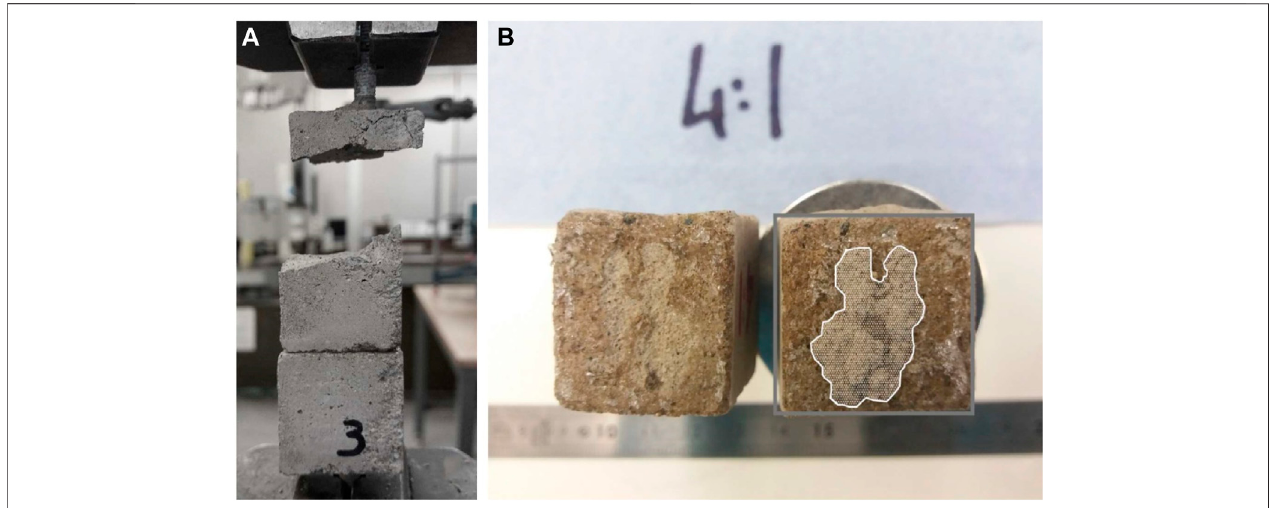
FIGURE5| Samplebondedwith theunmodi fi edcommercial CA: failure occurred inthe concrete sampleat thelevelofthe bolthead (A) ;bondedcross -sectionof the samples after testing (B) .